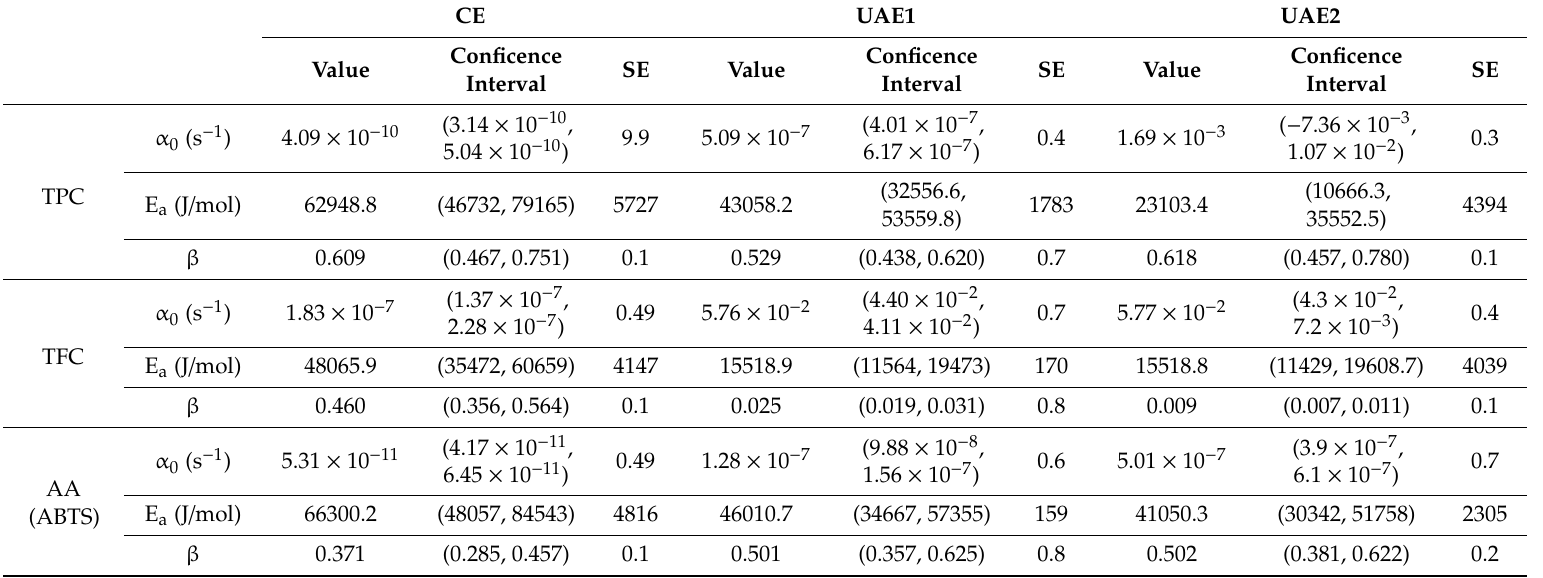
Table 3. Identified parameters ( α 0 , Ea and β ) for the proposed Weibull model to simulate the extraction yield curves of total polyphenol (TPC) and total flavonoid (TFC) contents, and antioxidant activity (AA) (ABTS assay) for mechanical agitation (CE at 80 rpm) and acoustically assisted (UAE1 at 520 W / L; UAE2 at 790 W / L) extraction; together with the confidence interval and standard error (SE) associated to each